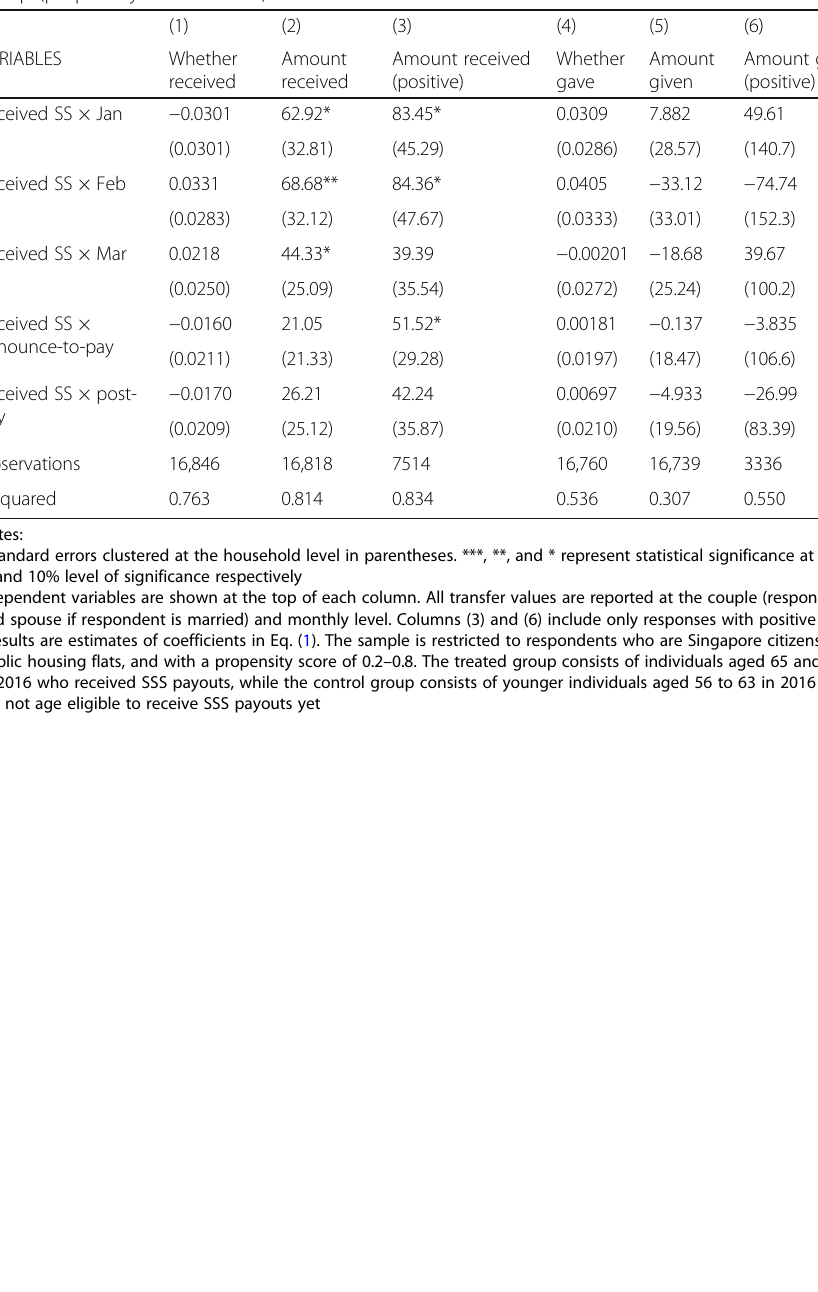
Table 16 Robustness check for private cash transfers — using non-age-eligible sample as a control group (propensity score 0.2 –